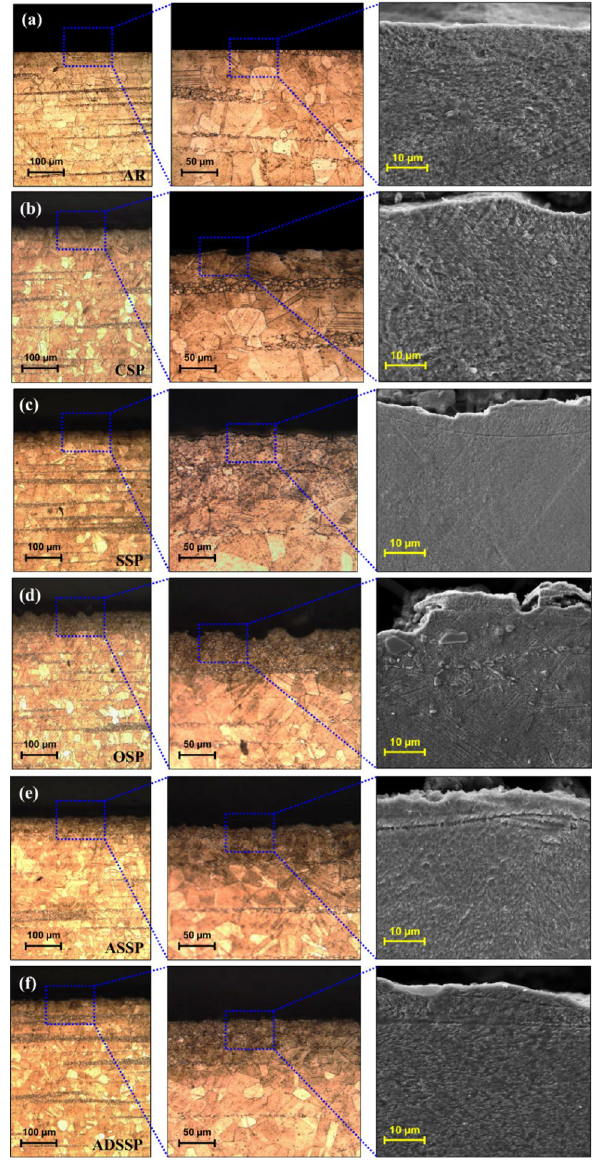
Figure 4. Cross-sectional OM and FESEM observations of the treated specimens of ( a ) AR core material, ( b ) CSP, ( c ) SSP, ( d ) OSP, ( e ) ASSP and ( d ) ADSSP exhibiting the plastically deformed surface layer and surface